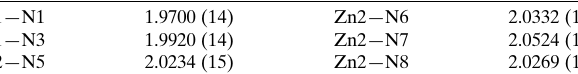
Table 2 Hydrogen-bond geometry and centroid–centroid distances for (cid:2) – (cid:2) interactions (A˚ , (cid:5) ).